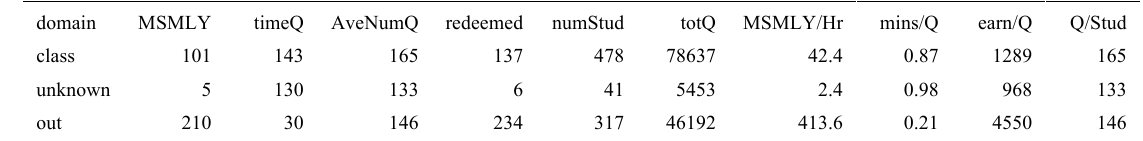
Table 2. Summary statistics August-September 2017 (mostly before converting self-registrations to faucets) for students inside and outside the tutor-web classes.